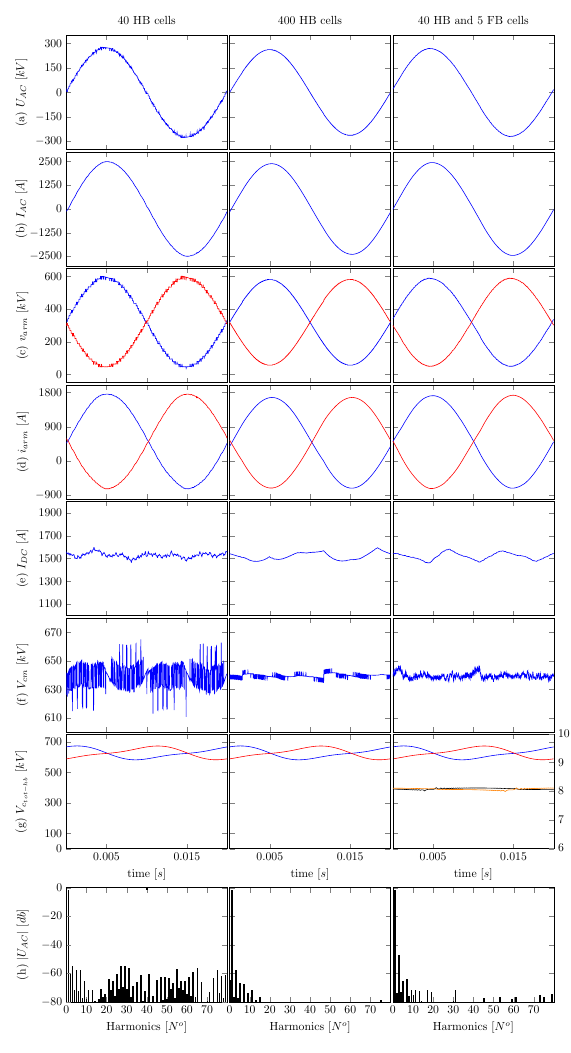
Figure 5. Waveform comparison between an HB-MMC with 40 ( left column ) and 400 ( middle column ) cells, and an EMMC with 40 HB cells and 5 FB cells ( right column